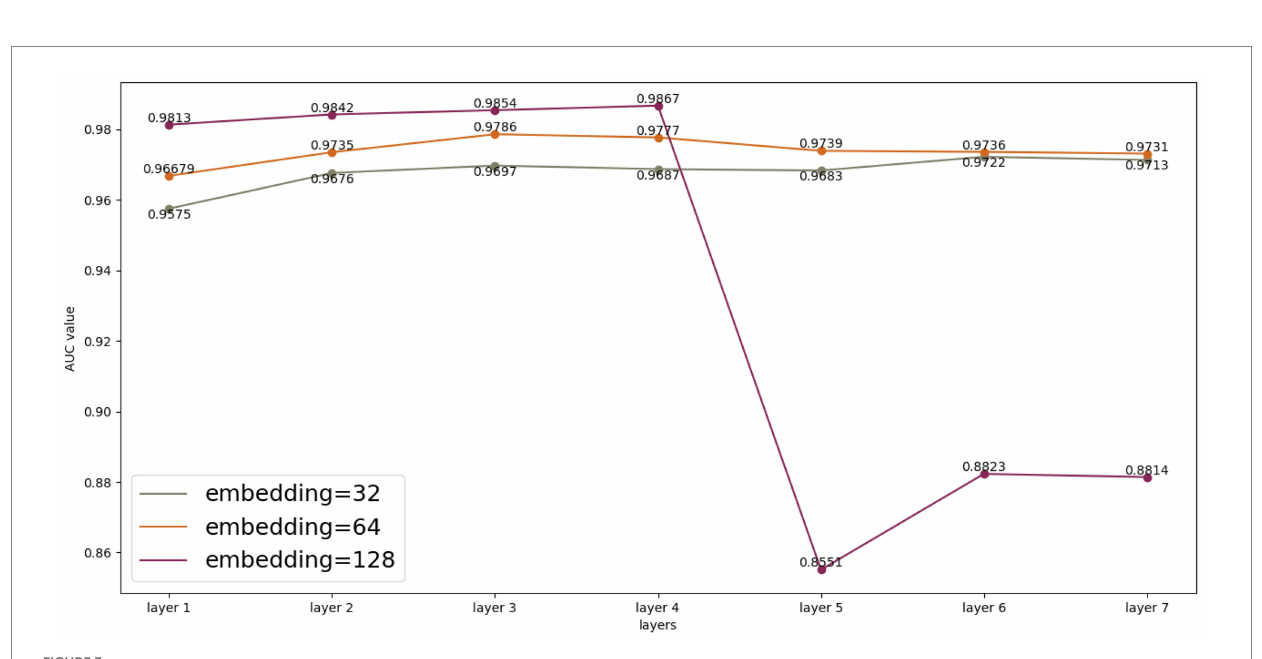
FIGURE 3 Model parameters analysis on the HMDAD dataset.